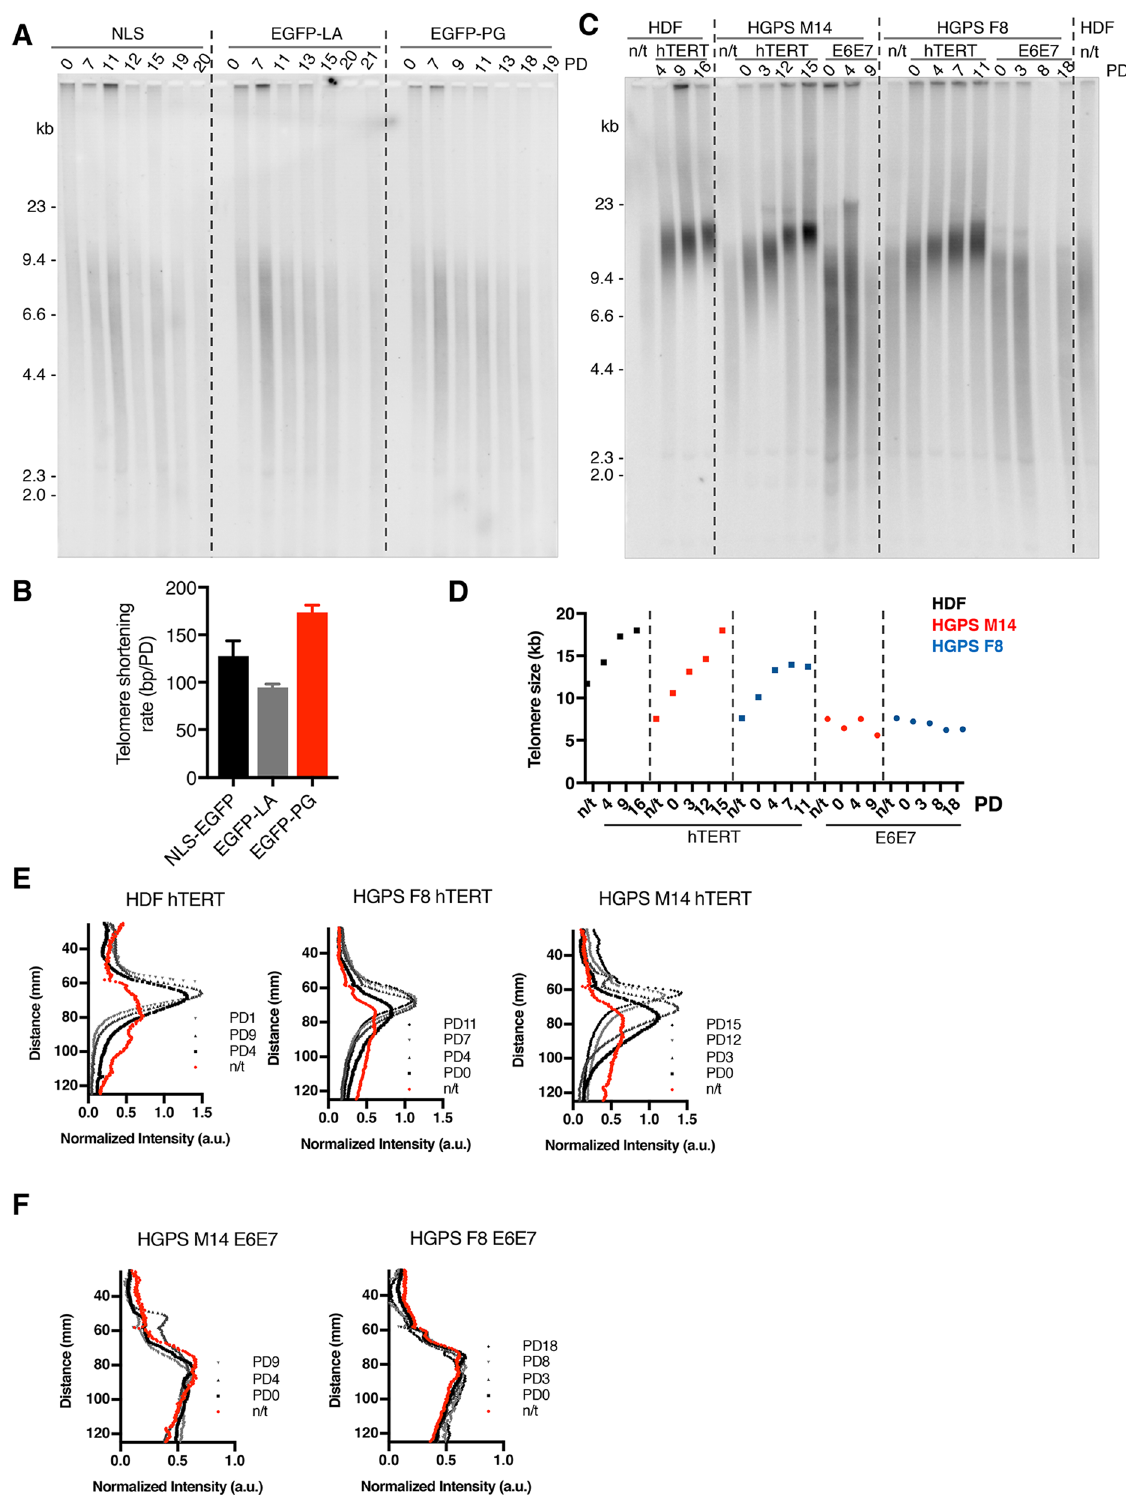
Figure 2. Critically short telomeres induce senescence in progerin-expressing cells. ( A ) Southern blot of terminal restriction fragments (TRF) of HDFs expressing NLS-EGFP, EGFP-LA and EGFP-PG. The cumulative population doublings (PD) are indicated. A representative exemple is shown from n = 2 experiments. ( B ) Telomere shortening rate quantified from two independent TRF analyses as in ( A ). Mean with SD is shown. ( C ) Southern blot of terminal restriction fragments (TRF) from normal HDF, HGPS M14, HGPS F8 cells before and after expression of hTERT or E6E7 (n = 1). The cumulative population doublings (PD) are indicated. ( D ) Quantification of TRF analyses from ( C ). The graph represent the telomere size in kb in the different cell lines with cumulative PDs. ( E,F ) Quantification of TRF analyses from ( C ) before (n.t.) or after hTERT expression ( E ) or E6E7 expression ( F ). The graphs represent the normalized signal intensity as a function of the distance on the gel, a proxy of telomere